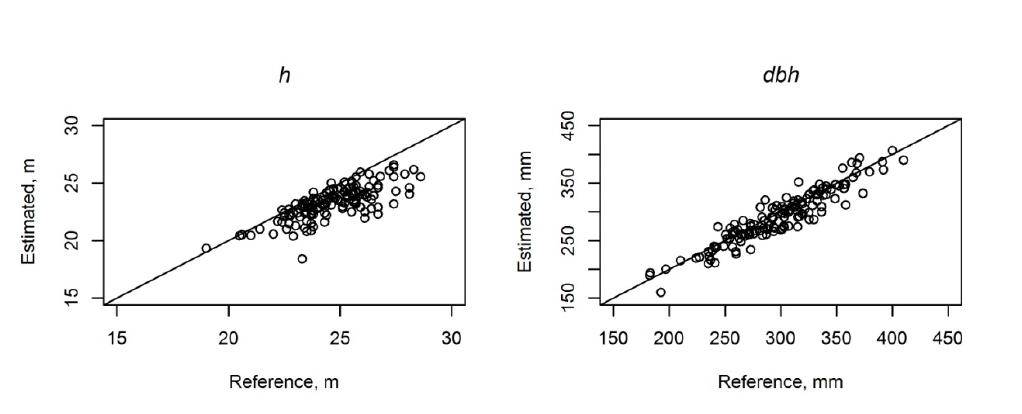
Figure 3. Field measured tree attributes (reference) against TLS measured tree attributes (estimated). The line represents a 1:1